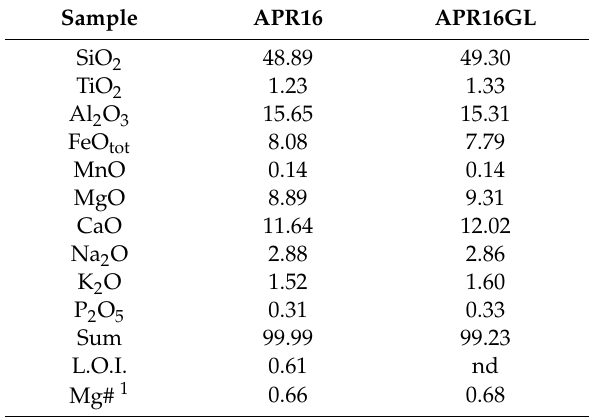
Table 1. Composition (wt. %) of APR16 rock sample and APR16GL starting material.